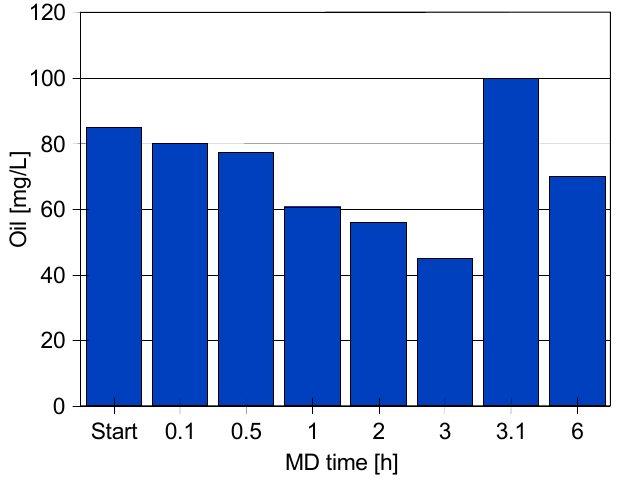
Figure 6. Oil concentration changes in the feed during the MD process of Baltic Sea water contami- nated by oil and SDS (1.5 mg/L). Module CMD.